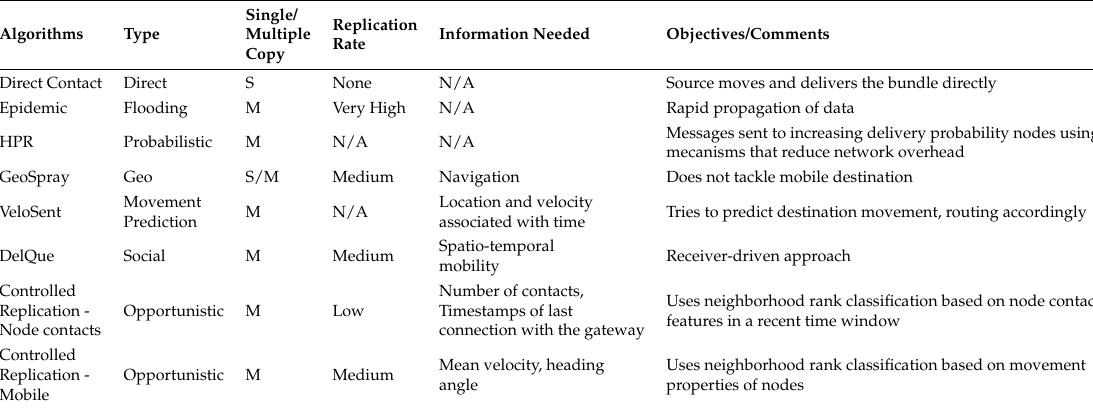
Table 3. Forwarding strategies overview.